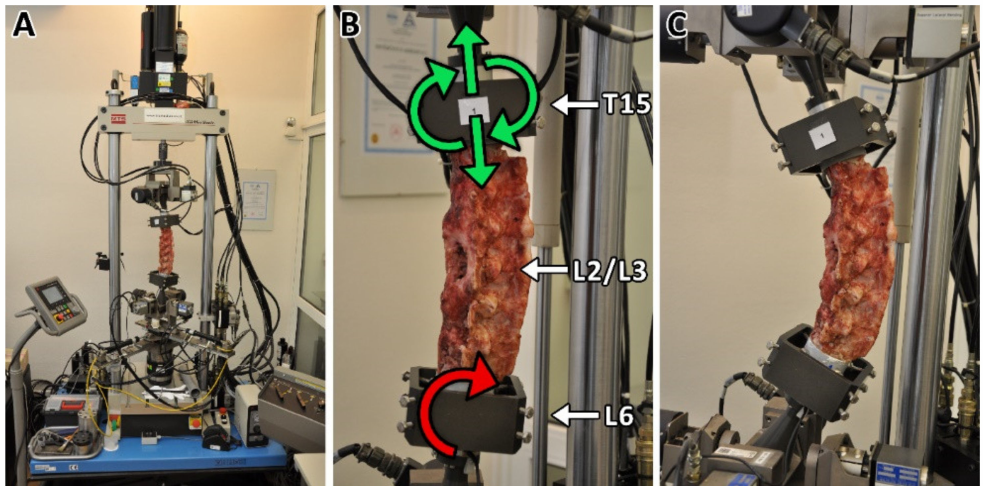
Figure 1. The MTS Bionix Spine Kinematics System ( A ) with fixed porcine spine cadaver. The inferior end of the lumbar spine cadaver (L6) was rigidly mounted on the platform on which the pure bending moment was applied ( B ). The superior end (T15) was unconstrained and free to move in the vertical direction and to rotate ( B ). The composite implants or bone graft were implanted from the lateral side between L2 and L3 vertebras. Pure bending moment was applied with a load limit of 5 Nm at a rotation rate of 20 ◦ /min in flexion (+40 ◦ )—extension ( − 40 ◦ ) mode ( C ). Each specimen was tested for three